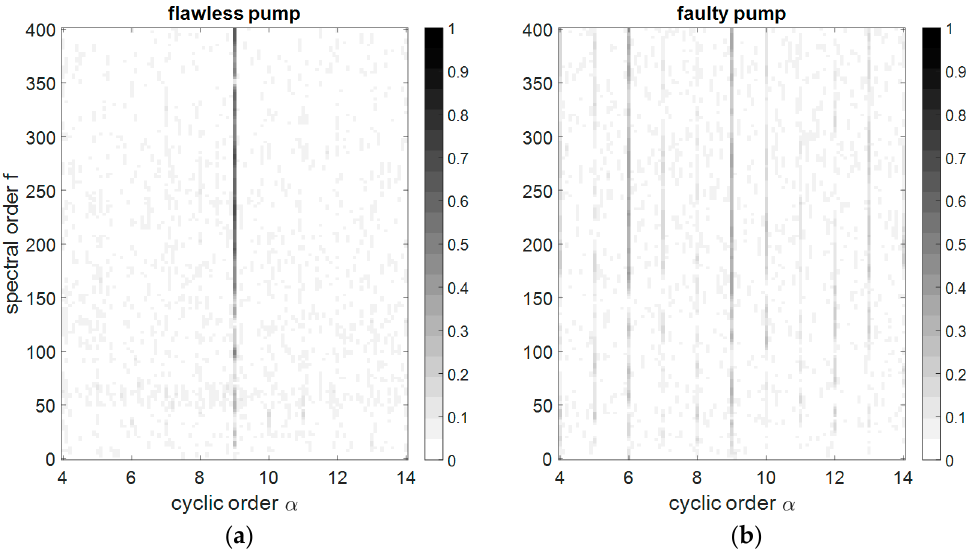
Figure 13. CSC around the cyclic order 9 for the signals acquired with sensor 1 at 1500 r/min and 150 bar ( ∆ α = 0.1, ∆ f = 2.5). ( a ) flawless pump; ( b ) faulty pump.